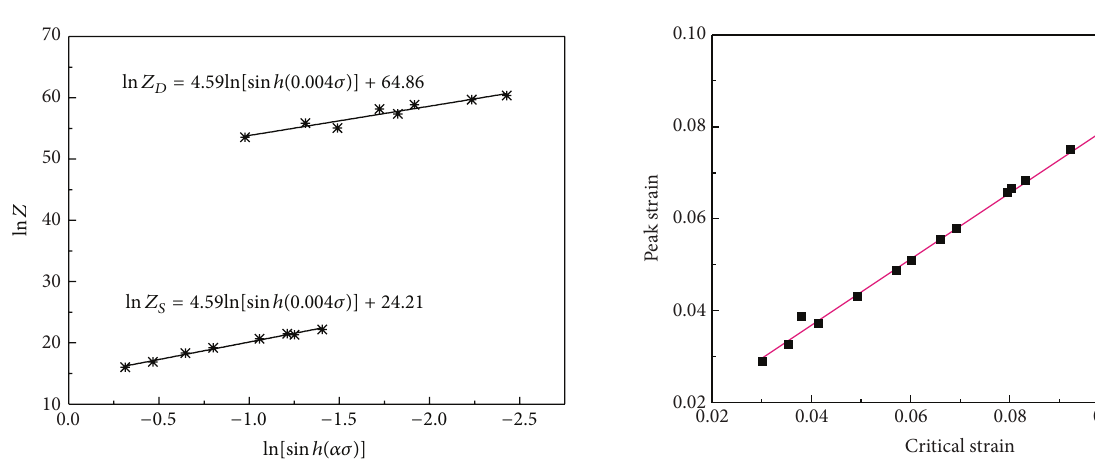
Figure 7: The relationships between ln 𝑍 and ln [ sinh (𝛼𝜎)] .